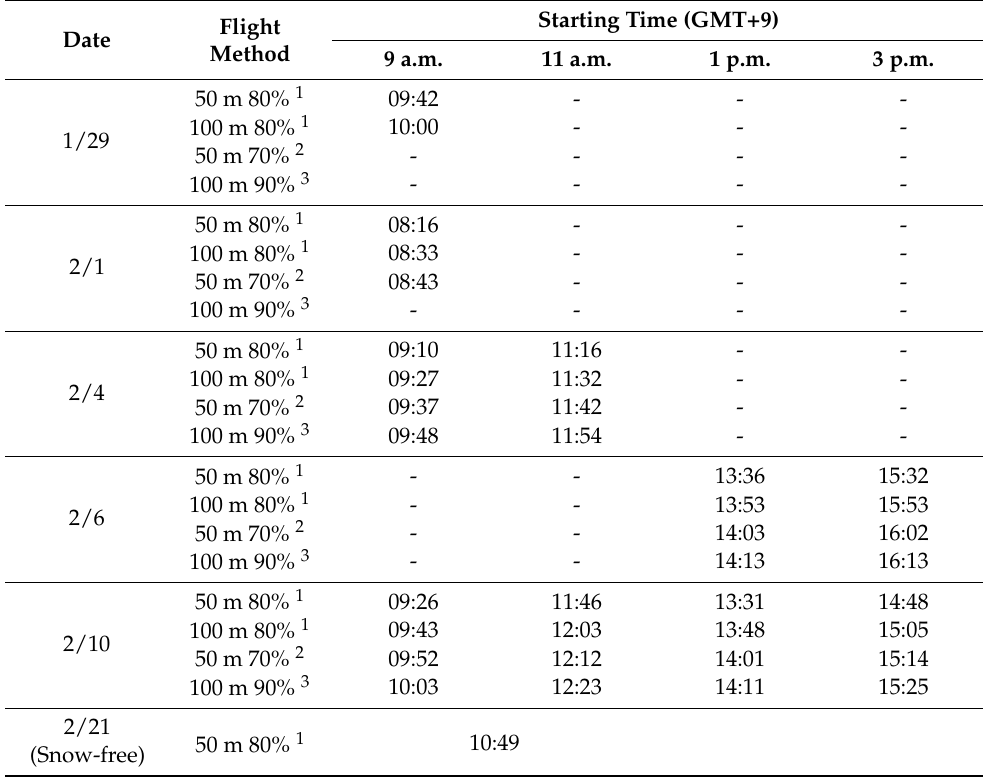
Table 2. Starting time of the drone surveying in this